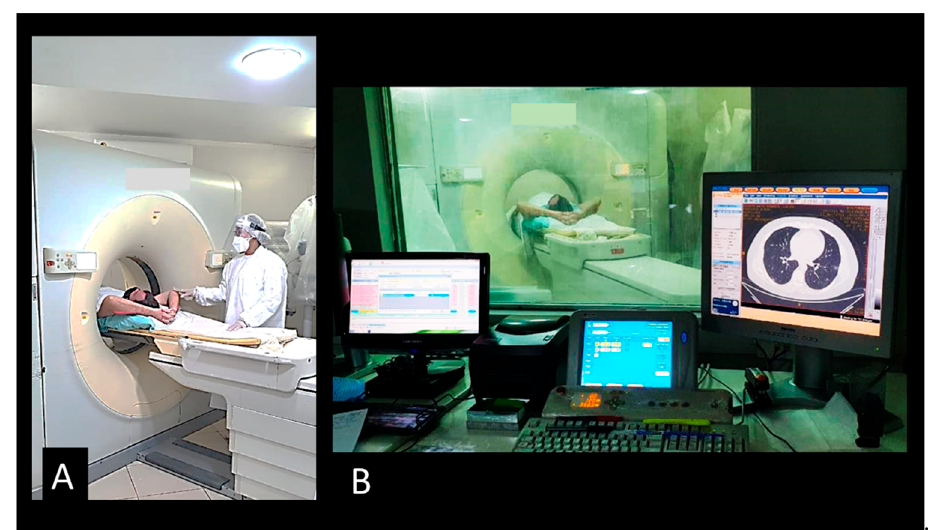
Figure 2. Moments during the performance of MRI on the brain of a patient with COVID ‐ 19 ( A ) Patient being positioned in the MRI machine with the brain coil having been placed. ( B ) Photo ‐ graph of the MRI Control Room during the examination and the acquisition of the brain magnetic resonance images of a patient with COVID ‐ 19.